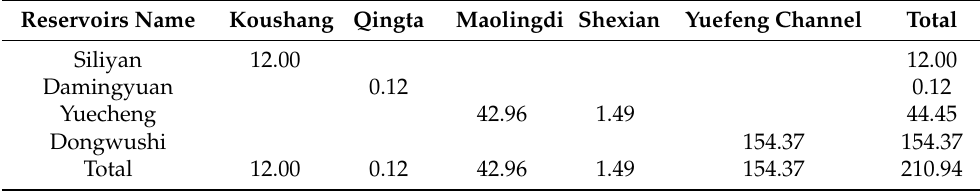
Table 6. Results of reservoir optimal operation in Handan (10 6 m 3 ).